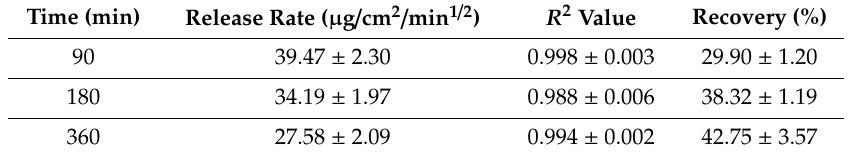
Table 4. Di ff erences in parameters observed by using various sampling duration (mean ±